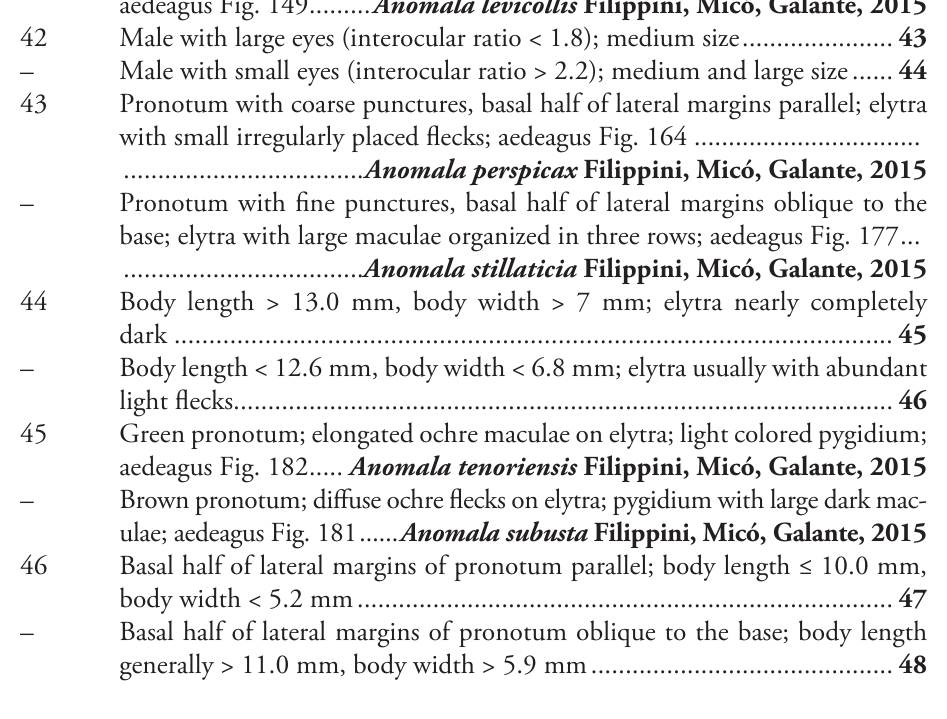
Parameres long and narrow, dorsal margin curved, ventral angle obtuse (Fig. – Parameres short and wide, dorsal margin sinuate, ventral angle pointing backwards in a lateral view (Fig. 189) .......................................................... 37 Elytra light colored with sparse flecks; body length > 14.1 mm ................ 38 – Elytra light colored and body length < 13.5 mm; or dark elytra and body 38 Presence of protuberance on clypeus; aedeagus Fig. 185 .............................. – Clypeus with even surface; aedeagus with different shape ......................... 39 39 Pronotum with irregular macula on its disc; elytra with large maculae; aedea- – Pronotum completely dark; elytra with small flecks; aedeagus Fig. 115 ........ 40 – 41 Pronotum completely dark; venter homogeneously bronze brown, metallic; third tooth of protibia weakly developed; body length > 13.2 mm; aedeagus Fig. 115 ................... Anomala aereiventris Filippini, Micó, Galante 2015 – Pronotum with ochre sides; venter brown with yellowish parts, without me- tallic luster; third tooth of protibia well developed; body length < 13.0 mm; aedeagus Fig. 149 ......... Anomala levicollis Filippini, Micó, Galante, 2015 42 Male with large eyes (interocular ratio < 1.8); medium size ...................... 43 – Male with small eyes (interocular ratio > 2.2); medium and large size ...... 44 43 Pronotum with coarse punctures, basal half of lateral margins parallel; elytra with small irregularly placed flecks; aedeagus Fig. 164 ................................. – Pronotum with fine punctures, basal half of lateral margins oblique to the base; elytra with large maculae organized in three rows; aedeagus Fig. 177 ... 44 Body length > 13.0 mm, body width > 7 mm; elytra nearly completely – Body length < 12.6 mm, body width < 6.8 mm; elytra usually with abundant 45 Green pronotum; elongated ochre maculae on elytra; light colored pygidium; aedeagus Fig. 182 ..... Anomala tenoriensis Filippini, Micó, Galante, 2015 – Brown pronotum; diffuse ochre flecks on elytra; pygidium with large dark mac- ulae; aedeagus Fig. 181 ...... Anomala subusta Filippini, Micó, Galante, 2015 46 Basal half of lateral margins of pronotum parallel; body length ≤ 10.0 mm, body width < 5.2 mm .............................................................................. 47 – Basal half of lateral margins of pronotum oblique to the base; body length generally > 11.0 mm, body width > 5.9 mm ............................................